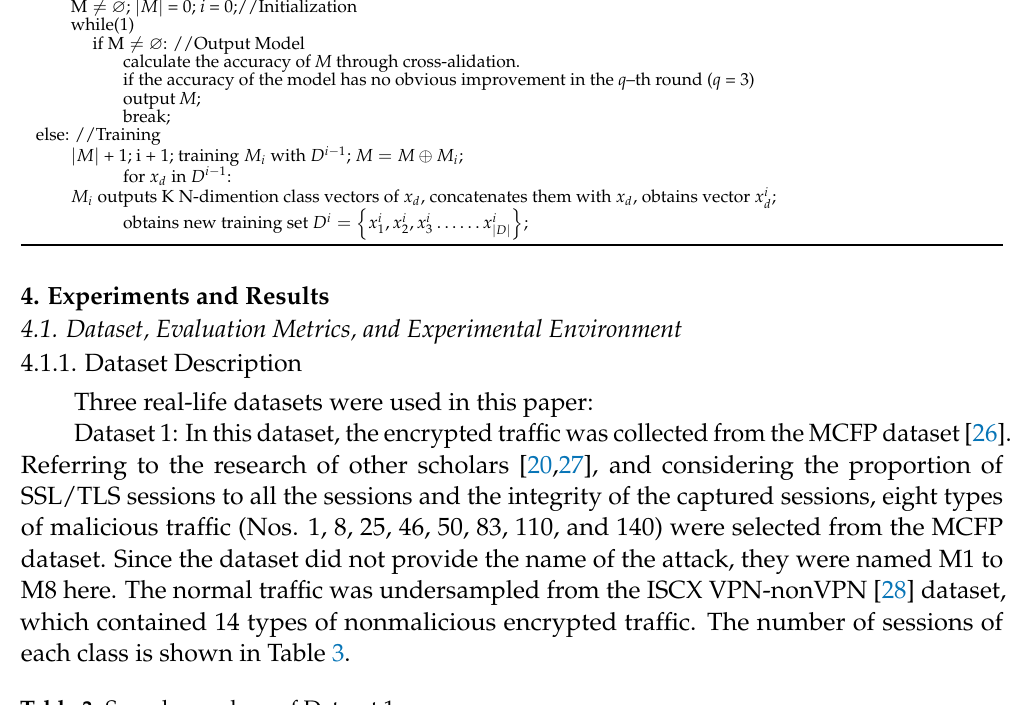
Table 3. Sample numbers of Dataset